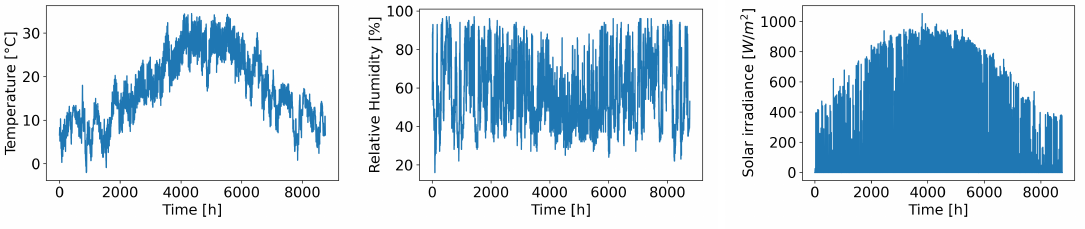
Figure 10. Ambient temperature, relative humidity and solar irradiance on a horizontal surface for standard Croatian littoral climate (typical meteorological